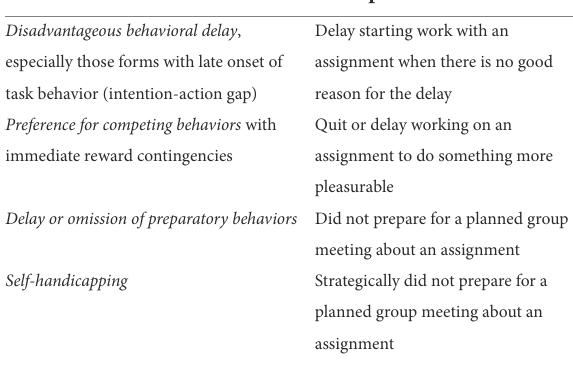
TABLE 2 Procrastinatory behaviors, given “working with an assignment” as the activity